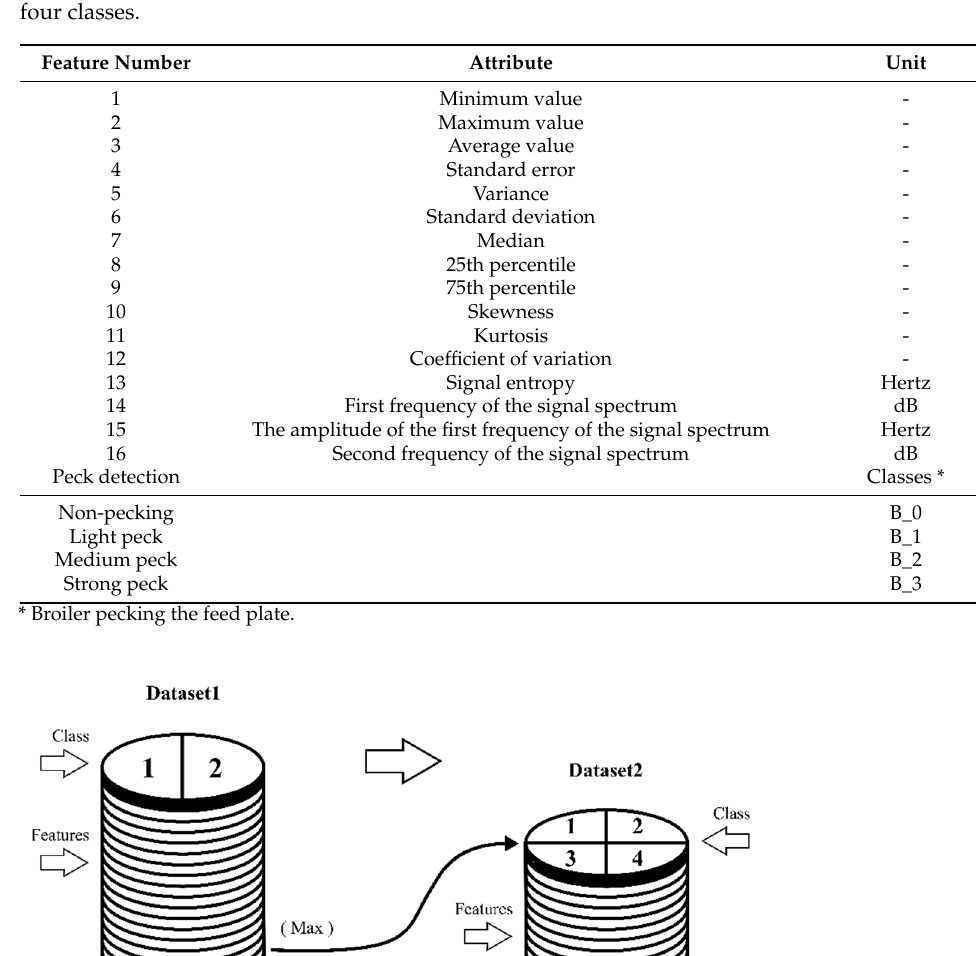
Table 2. Attributes included in the second dataset in the detection of pecking of broilers with four classes.